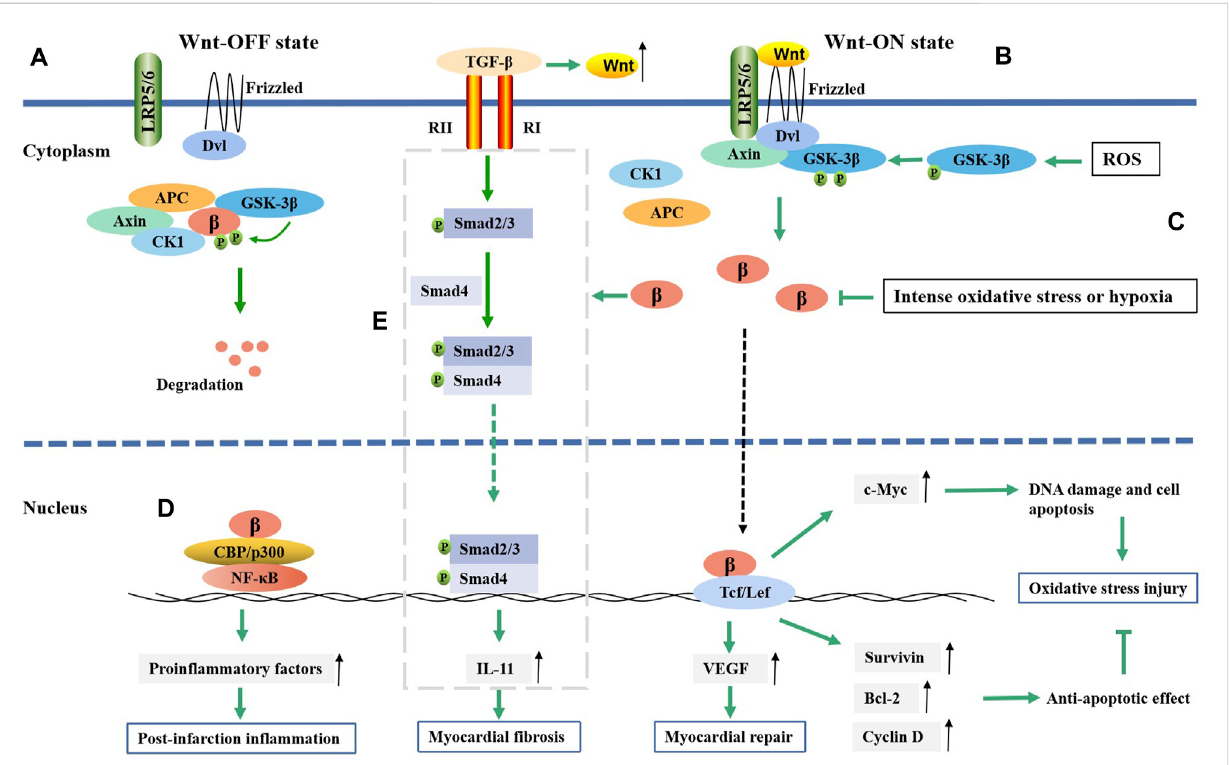
FIGURE 1 The regulatory mechanism of Wnt/ β -catenin pathway in myocardial infarction. (A) In the absence of Wnt ligands, Wnt/ β -catenin pathway is suppressed. (B) In the presence of Wnt ligands, Wnt/ β -catenin pathway is activated. Then isolated β -catenin can translate into nucleus and bind to TCF/ LEF, which will result in gene transcription such as Bcl-2, survivin, cyclin D1, c-Myc, etc. The exression of Bcl-2, survivin and cyclin D1 could inhibit oxidative stressinjury,whilec-Mycexhibitsan opposite effect. (C) ROS promotes thephosphorylationofGSK-3 β andthen activetheWnt/ β -catenin pathway, while intense oxidative stress or hypoxia can decrease the level of β -catenin. (D) β -catenin promotes NF- κ B target genes expression through forming complex with NF- κ B, which then promote post-infarction in fl ammation. (E) β -catenin can promote the TGF- β -mediated IL-11 expression in some way, which then induces the fi broblast-to-myo fi broblast transition; β , β